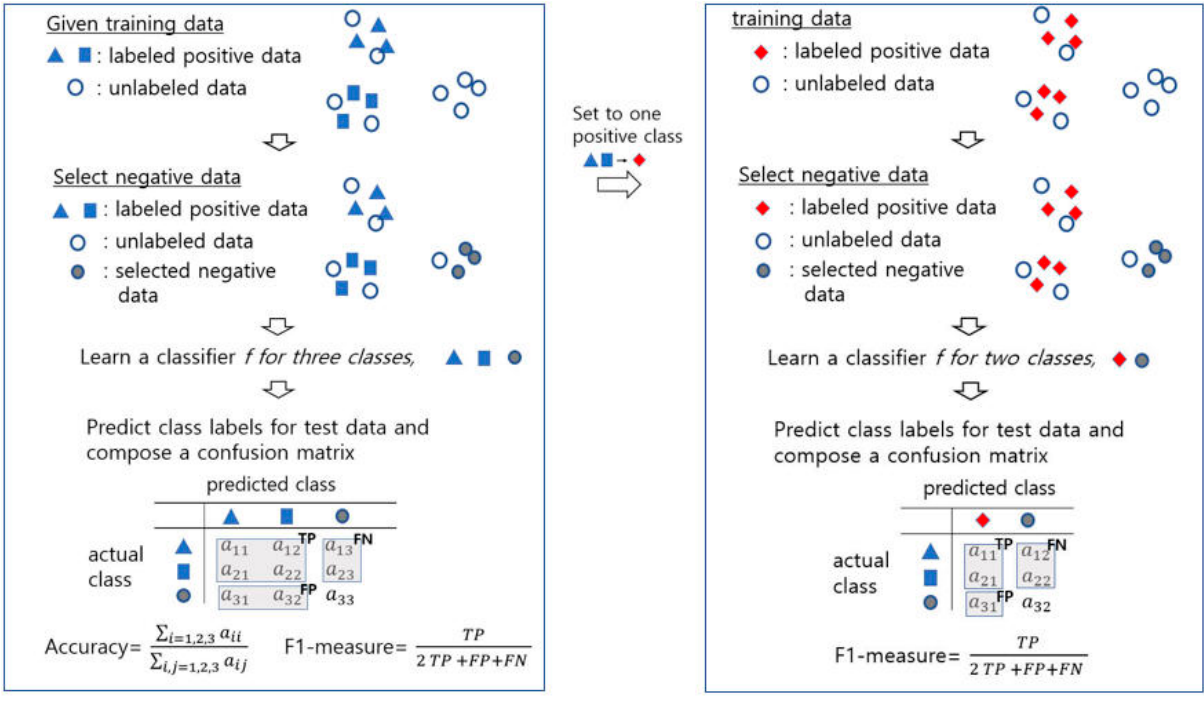
Figure 1. An example of MPU learning and PU learning .